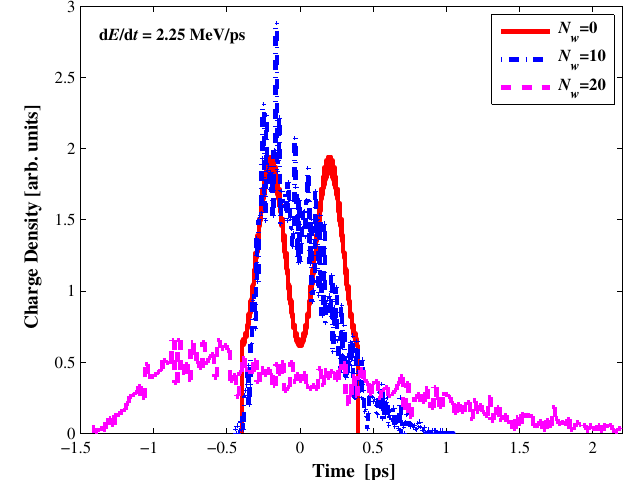
FIG. 11. Charge density of a N m ¼ 2 long premodulated, energy chirped (the chirp rate of dE=dt ¼ 2 . 25 MeV = ps) beam pulse at the entrance (solid line), and after N w ¼ 10 (dot-dashed line) or after N w ¼ 20 (dashed line) wiggler ’ s periods. The beam charge is Q b ¼ 1 nC, the initial modulation depth and frequency are m ¼ 50% and f m ¼ 2 . 5 THz,